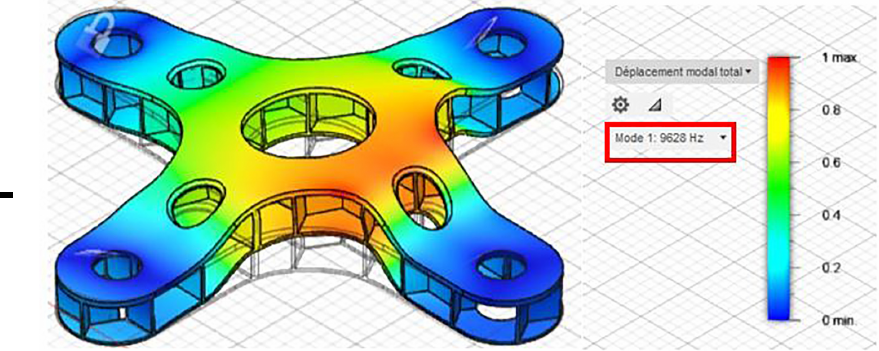
Figure 13. Vibration analysis of the holder